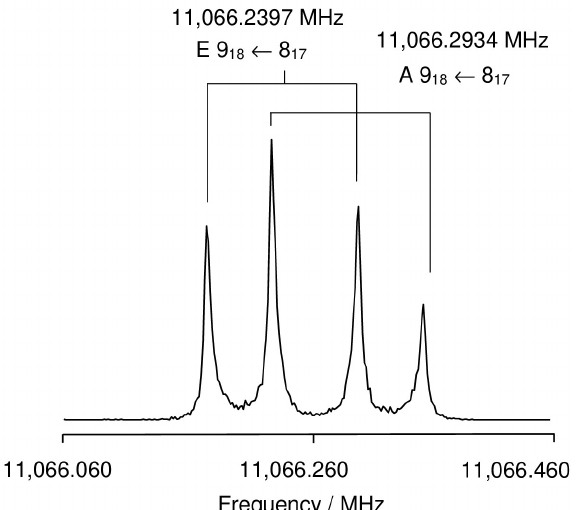
Figure 3. A high-resolution measurement of the 9 18 ← 8 17 transition of conformer I of MHO. The polarization frequency is 11,066 MHz for this spectrum, and 96 free induction decays were co-added.